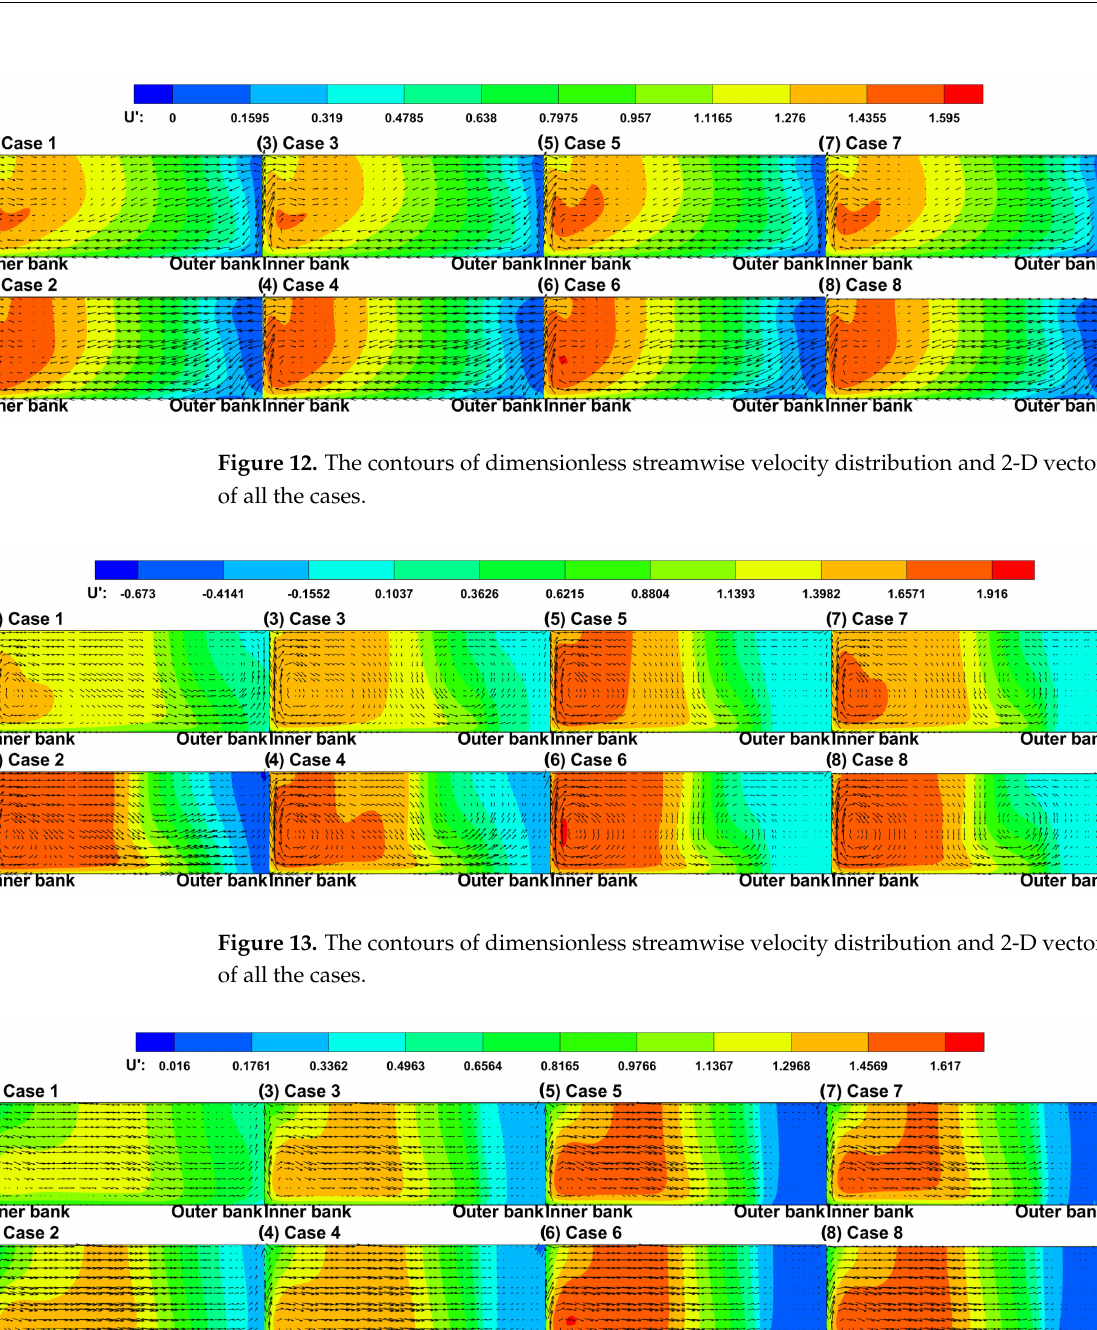
Figure 14. The contours of dimensionless streamwise velocity distribution and 2 ‐ D vectors on CS. 3 of all the cases.